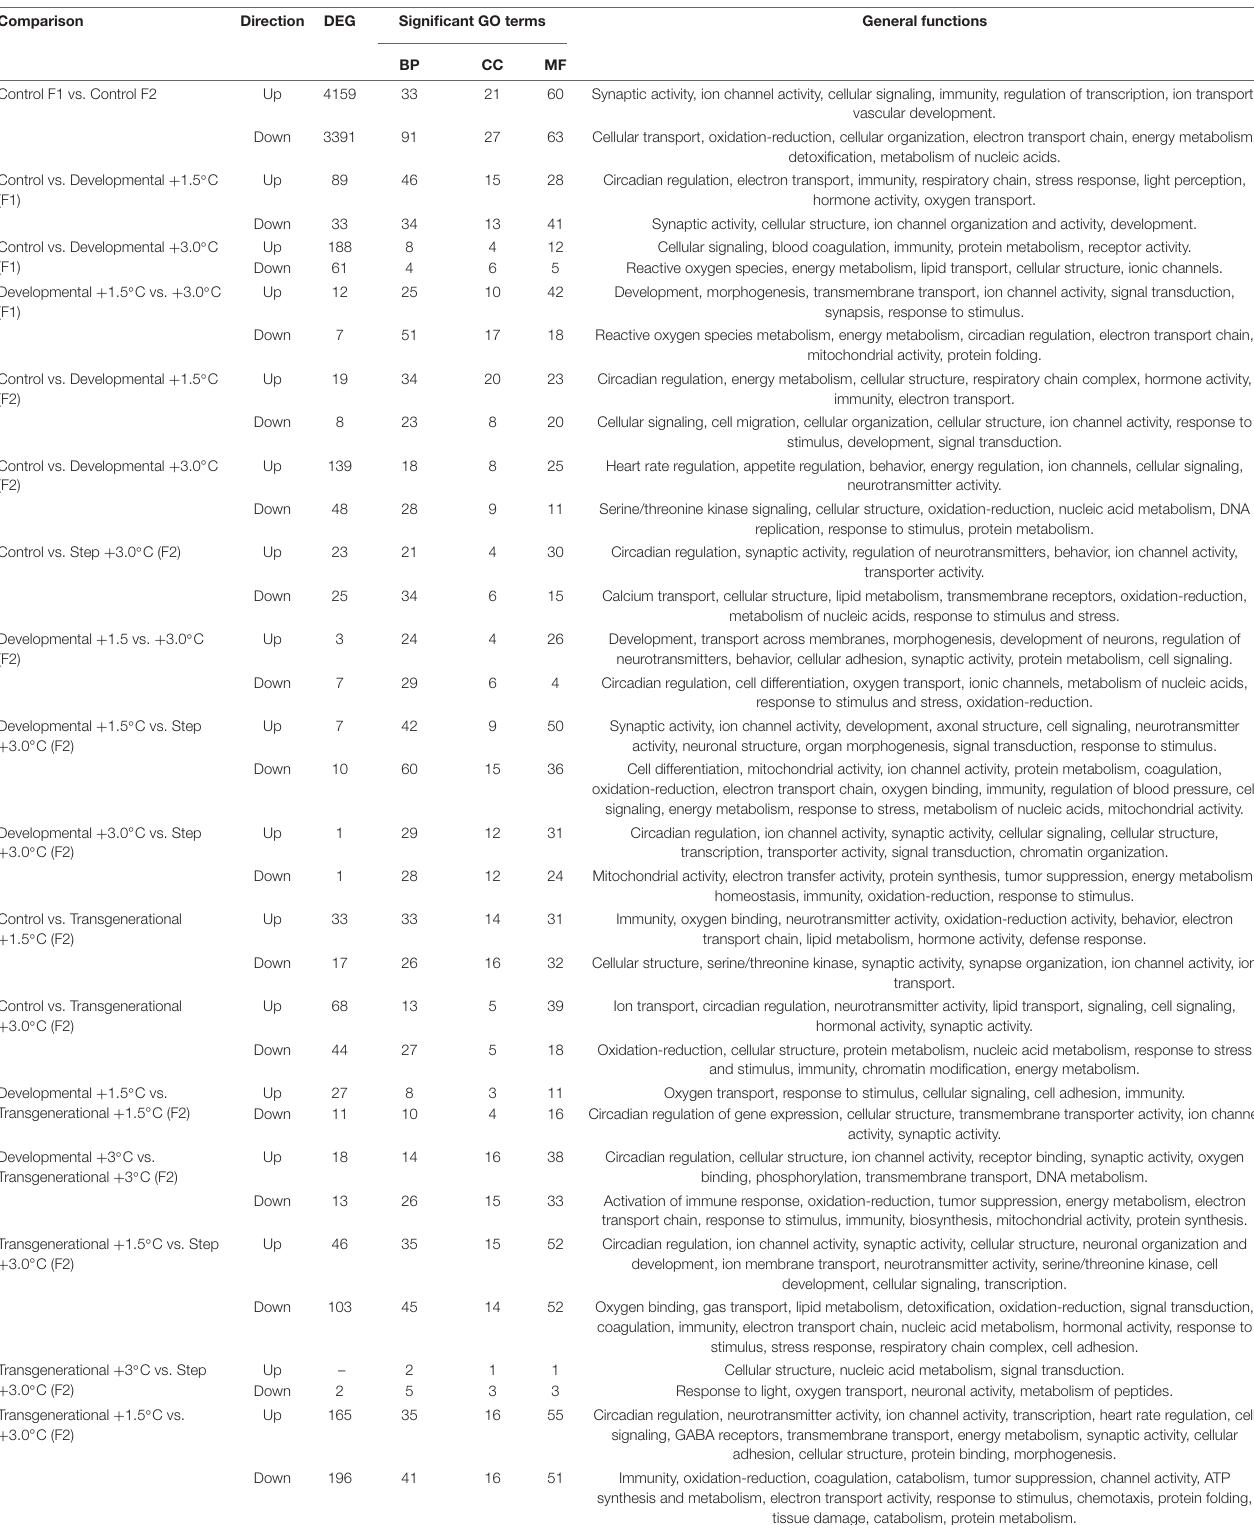
TABLE 1 | Number of differentially expressed genes (DEGs) and significant Gene Ontology (GO) categories between specific thermal comparisons, for each of the GO domains: Biological Process (BP); Cellular Component (CC); and Molecular Function (MF). Comparison Direction DEG Significant GO terms General functions